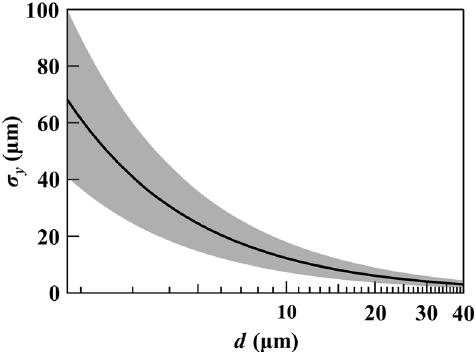
FIG. 7. Detectable source size range (gray area) as a function of slit separation d for a 0.01 visibility uncertainty. The solid curve shows the optimized detectable source size given by Eq. (17) with λ ¼ 0 . 827 Å ( E ¼ 15 keV) and p ¼ 6 . 6